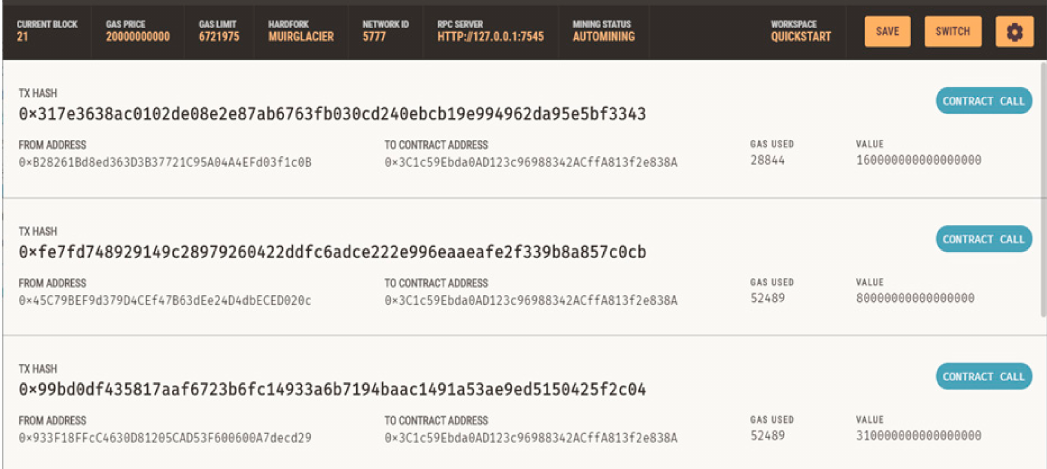
Figure 16. Blocks encrypted with 256-bit transaction